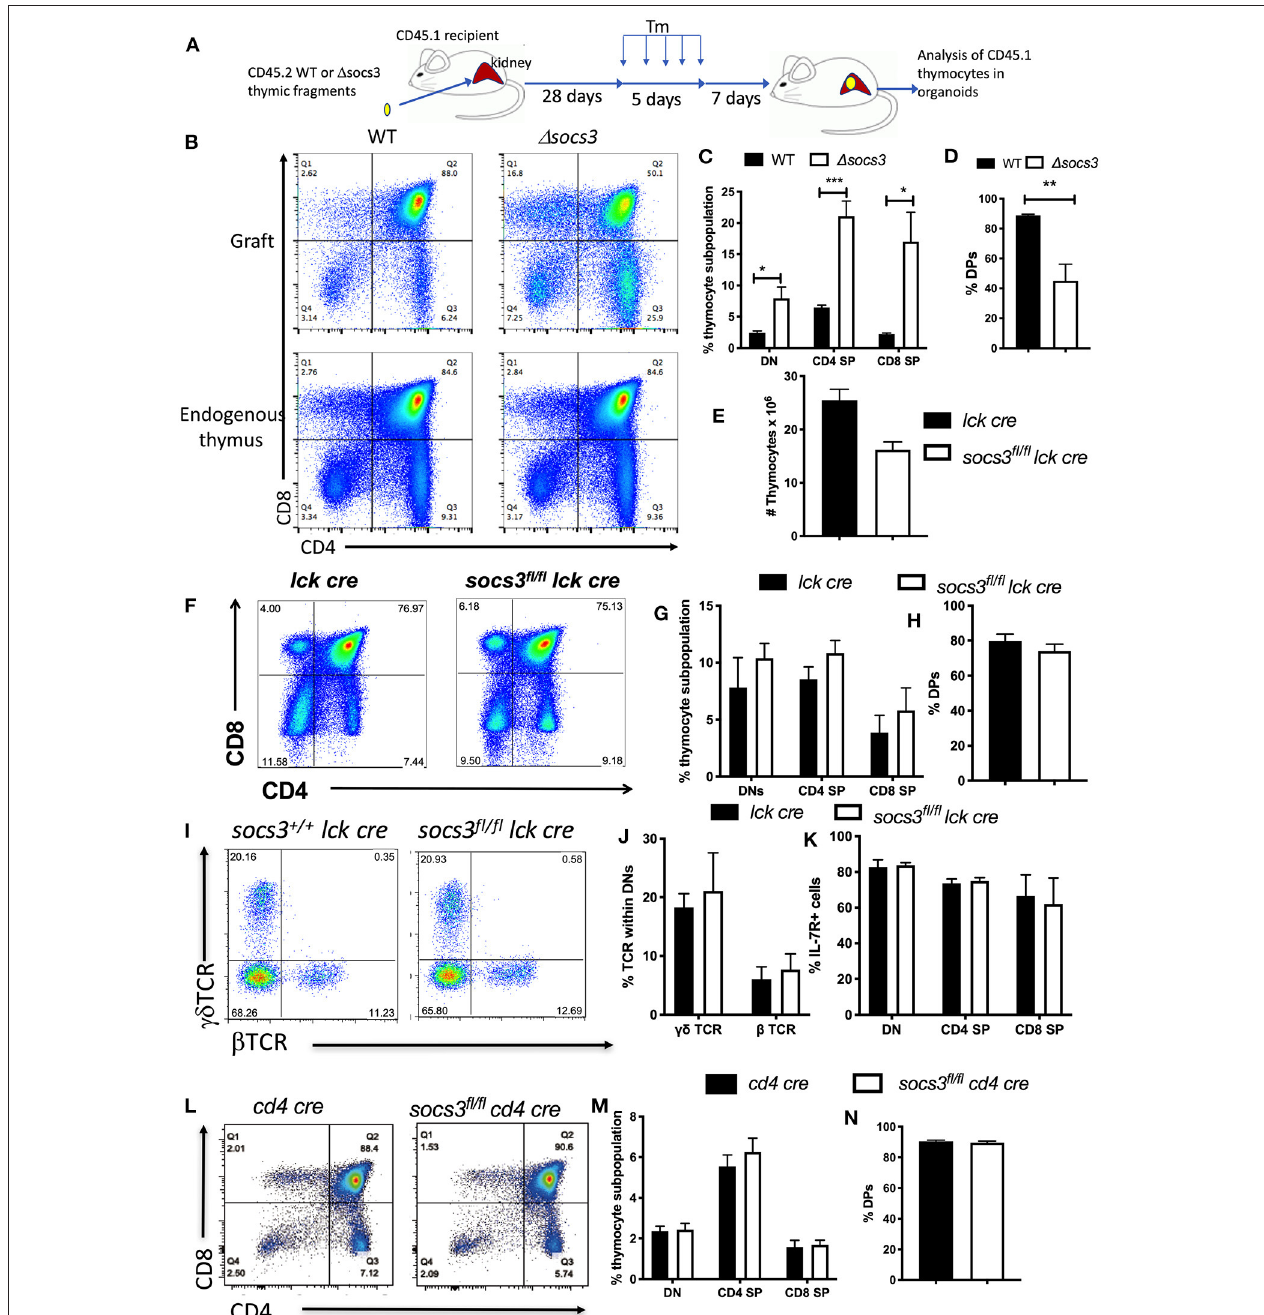
FIGURE 3 | SOCS3 expression in thymic stroma but not in thymocytes is required for T cell maturation in the thymus. (A) Thymic fragments from 1 to 3 days old WT and 1 socs3 mice were transplanted into the kidney capsule of CD45.1 + mice. Four weeks after the implantation mice were treated with Tm daily for 5 days. Seven days after the last Tm dose mice were sacrificed and the thymic organoid grafts and the “endogenous” thymus were explanted for analysis. (B) Representative dot plots shown compare the thymocytes from mice grafted with CD45.2 WT and 1 socs3 thymic fragments and the endogenous thymus (gated on CD45.1 + recipient cells), 7 days after the last Tm dose. (C,D) The mean frequencies of CD45.1 + DN, DP, CD4 SP, and CD8 SP ± SEM in the thymic grafts obtained as indicated above are shown. Differences between groups are significant at * p ≤ 0.05, ** p ≤ 0.01, *** p ≤ 0.001 (unpaired Student’s t- test). These experiments were performed 3 times. (E) The mean number of Socs3 fl / fl lck cre and Socs3 + / + lck cre thymocytes ± SEM (at least 6 per group) are depicted. (F) Representative dot plots and (G,H) the mean frequencies of Socs3 fl / fl lck cre and lck cre DN, DP, CD4 SP, and CD8 SP ± SEM are shown. (I) Representative dot plots and (J) mean frequencies ± SEM of Socs3 fl / lck cre and Socs3 + / + lck cre γδ and β TCR DN cells ± SEM are depicted. (K) The frequency of IL-7R + Socs3 fl / fl lck cre and Socs3 + / + lck cre thymocyte populations ± SEM mice are shown. (L) Representative dot plots and (M,N) the mean frequencies of DN, DP, CD4, and CD8 SP thymocytes ± SEM in Socs3fl/fl cd4 cre and Socs3 + / + cd4 cre mice are shown.